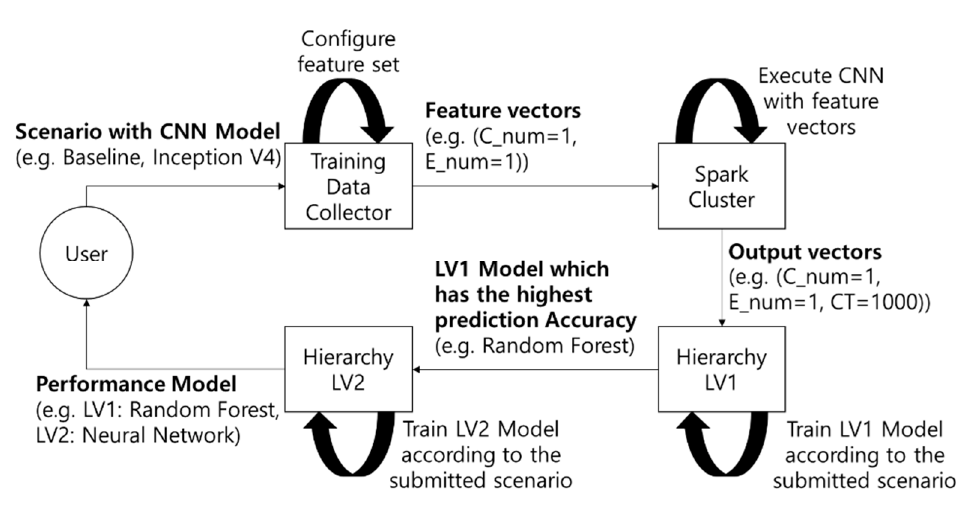
Figure 2. The performance model building procedure.